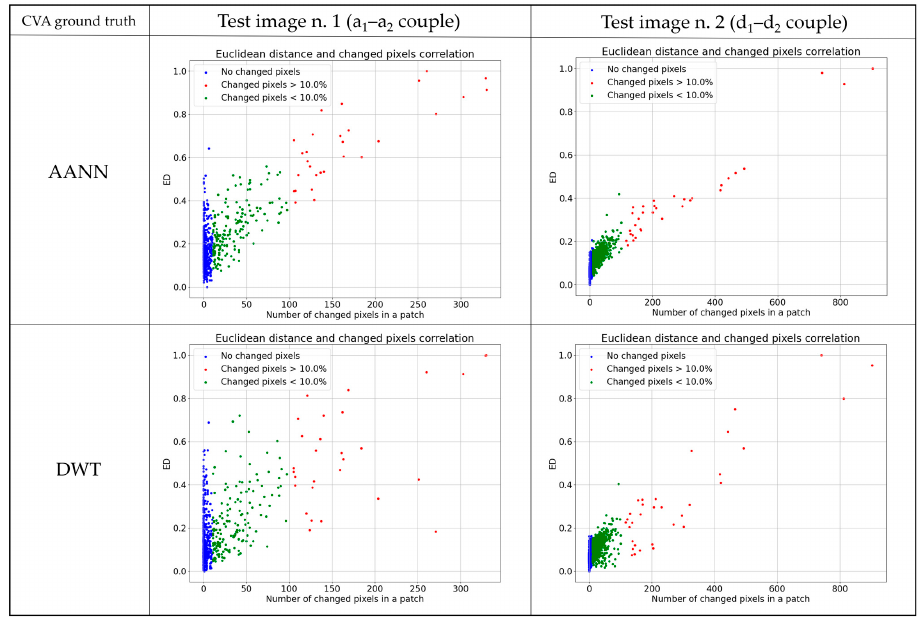
Figure 15. Correlation between the number of changed pixels in a ground truth patch ( x -axis) and the corresponding ED value ( y -axis) for test image 1 in Figure 11(a 1 ,a 2 ) ( left ) and test image 2 in Figure 11(d 1 ,d 2 ) ( right ). Each marker is colored according to the change condition in the CVA ground truth patch.